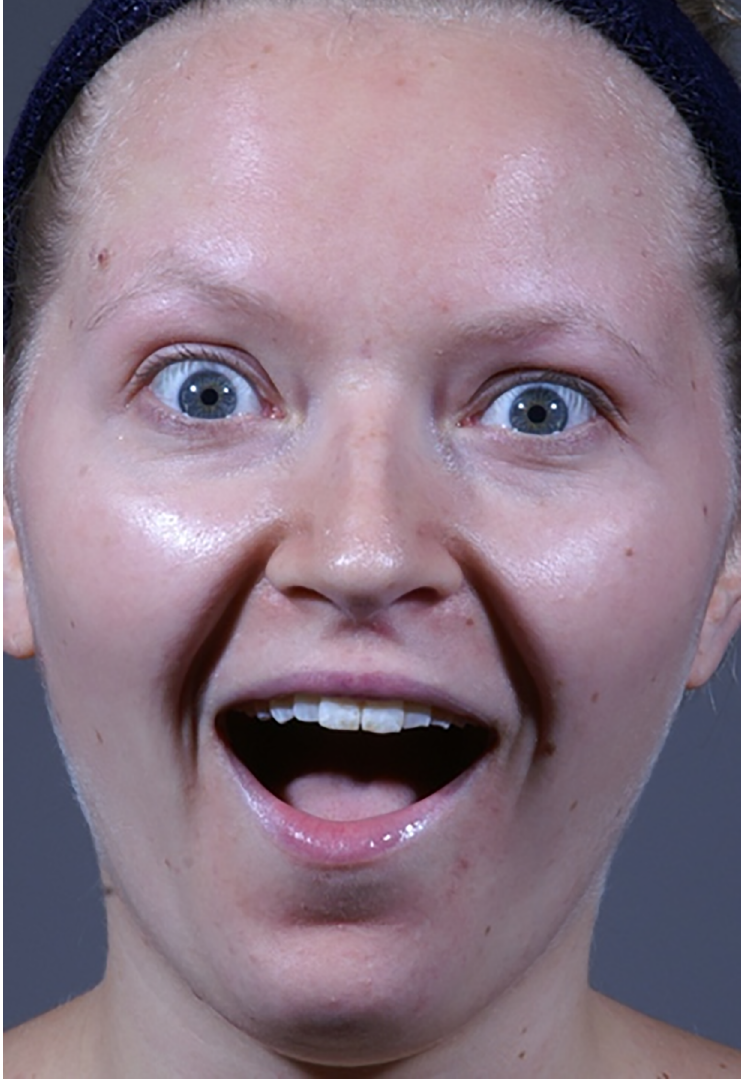
Fig 1. Happy-surprised example. Example of a positive happy-surprised stimulus face used in the present study [35].